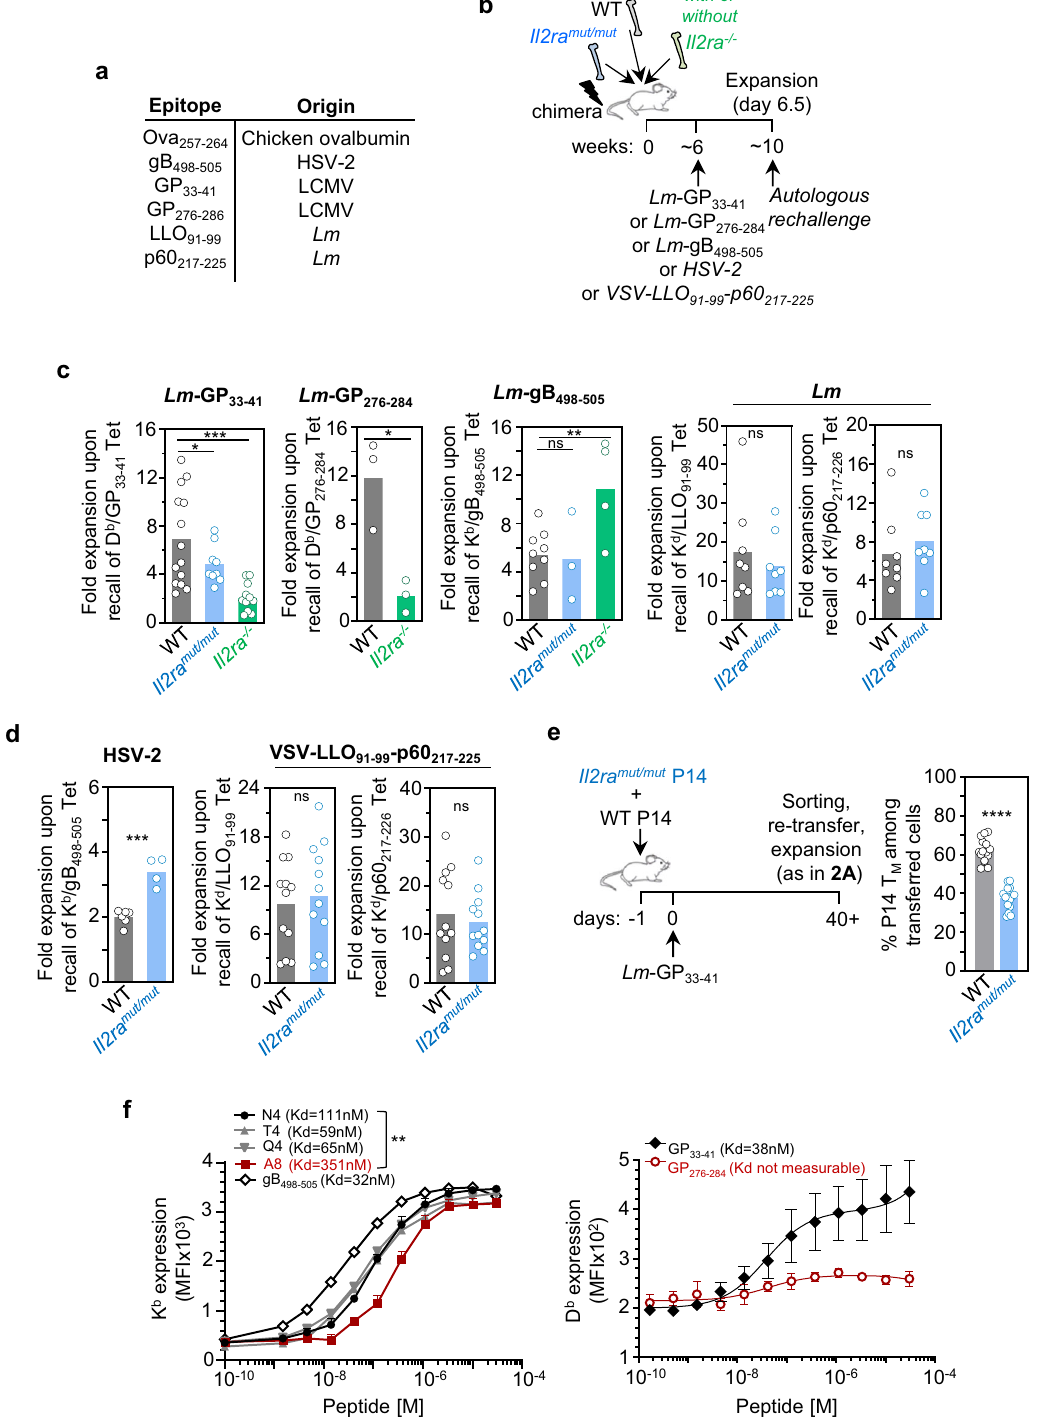
also did not depend on IL-2 to form functional memory cells, similarly to when they were expressed in Lm (Fig. 3d). Using the clonal population of GP 33 – 41 /D b -speci fi c Il2ra mut/mut and WT P14 TCR transgenic memory CD8 + T cells primed upon Lm -GP 33 – 41 infection, we further con fi rmed that P14 memory CD8 + T cells also failed to competitively expand when IL-2 signals were impaired (Fig. 3e). Notably, during primary infection of the chimera mice, some epitopes (Ova 257 – 264 , gB 498 – 505 ) but not others (GP 33 – 41 ) required IL-2 signals for optimal expansion, whether expressed